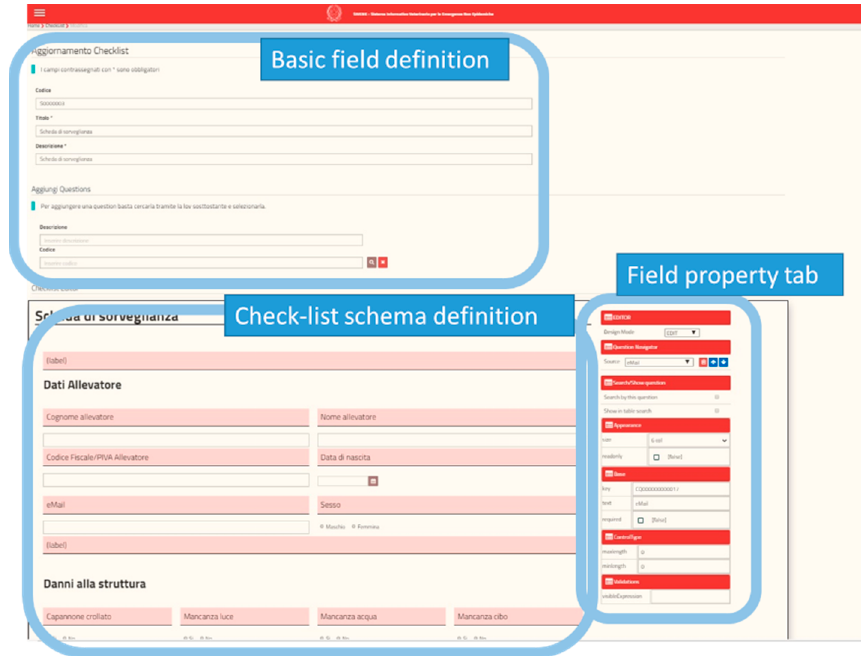
Figure 3. Survey editor to dynamically build checklists. The admin user, using this feature, can build a new checklist. The figure shows the different sections of the tool: a section for a basic element definition; a section to define the schema of a new checklist where, using drag ‐ and ‐ drop, it is possible to combine several basic elements; and a property tab to define the basic characteristics of each field (such as type, position, dimension, etc.).